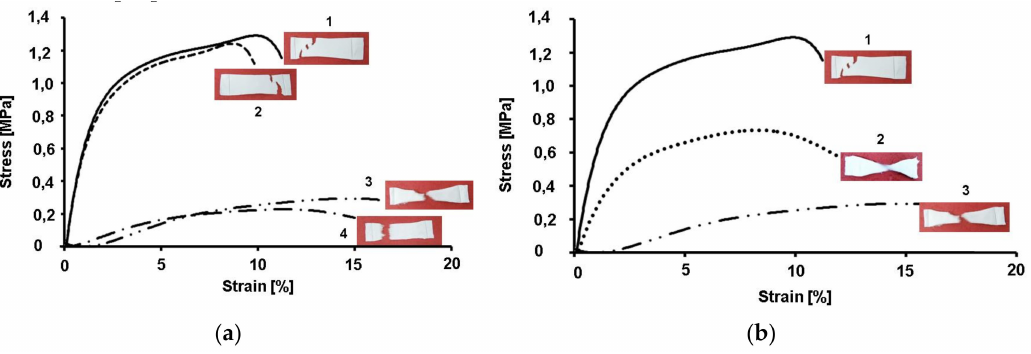
Figure 4. Stress–strain curves of membranes: ( a ) 1. CA, 2. CA / 5-Cl8Q, 3. CA / PEG and 4. CA / PEG / 5-Cl8Q; ( b ) 1. CA, 2. CA / PEO 100,000 and 3. CA / PEG 2000